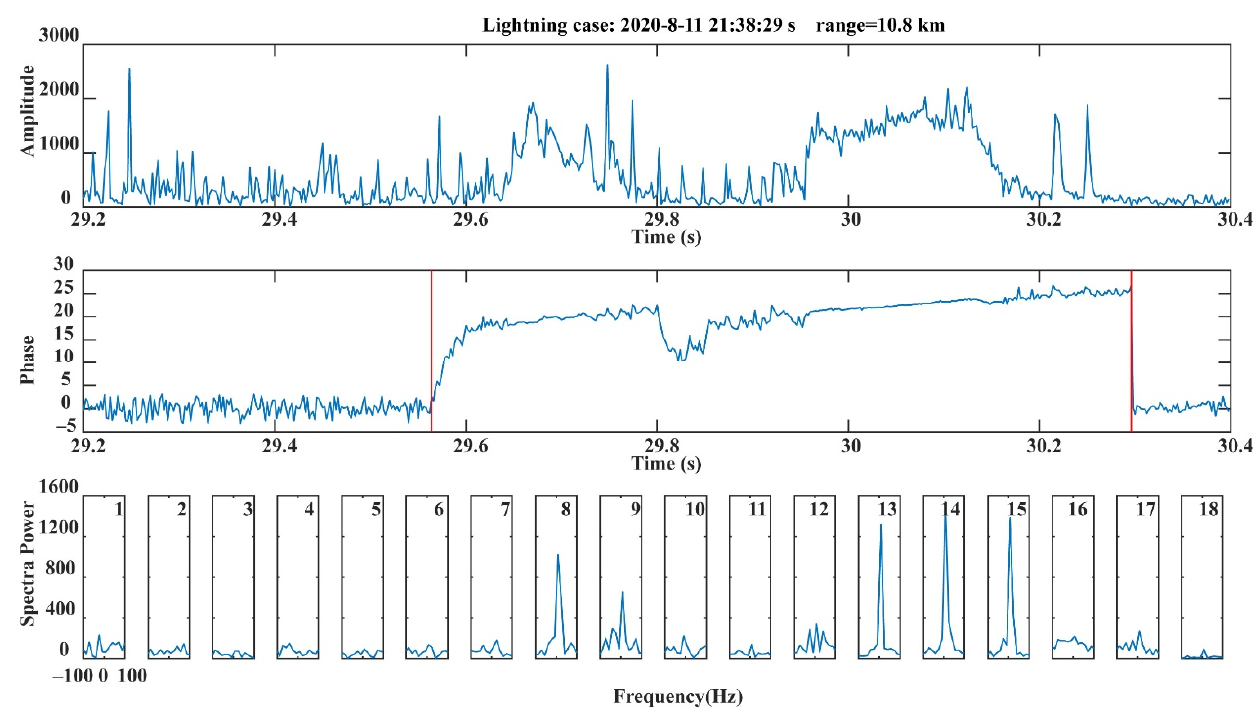
Figure 7. RTI plot of the received lightning echo.